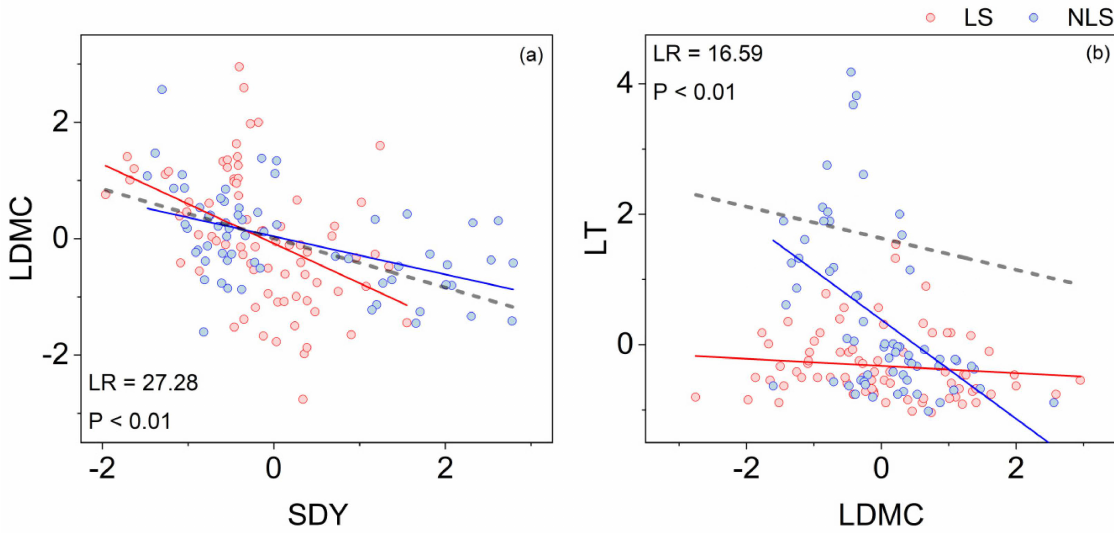
Figure 7. SMA of correlation among woody plant functional traits between landslides and nonland- slides. Subfigures ( a , b ) show the binary relationships between different functional traits. Colors indicate individual WFTs; broken black lines indicate significant relationships in the full dataset; the LR tests indicate significant differences between the slope of the WFT-specific SMA lines; only significantly different combinations in SMA analysis are listed here. Abbreviations are as follows: LDMC, leaf dry matter content; SDY, stem density; LT, leaf